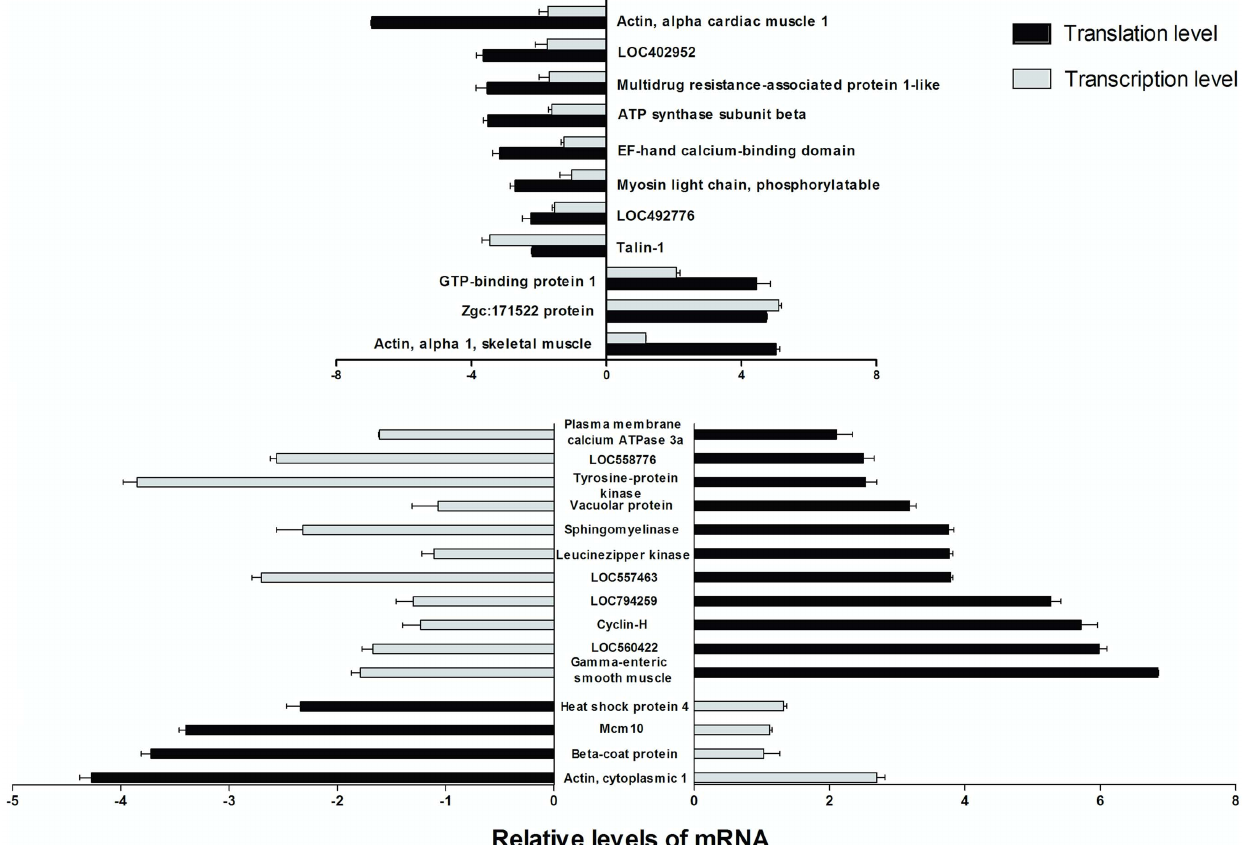
Figure 3. The relative mRNA transcription levels and translation levels of the positive proteins.